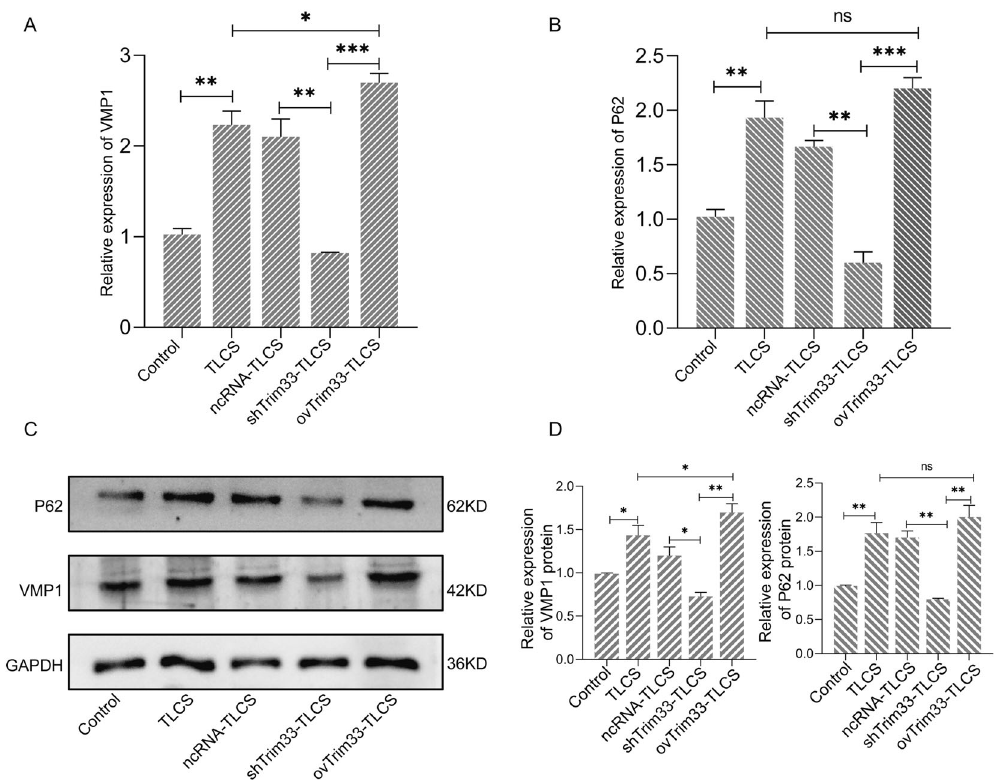
Fig. 5 Trim33 can activate zymophagy and regulate its activity and ef fi ciency. A The mRNA expression levels of VMP1; B the mRNA expression levels of P62; C , D the protein levels of VMP1 and P62 ( t -test, *** p < 0.001, ** p < 0.01, * p <